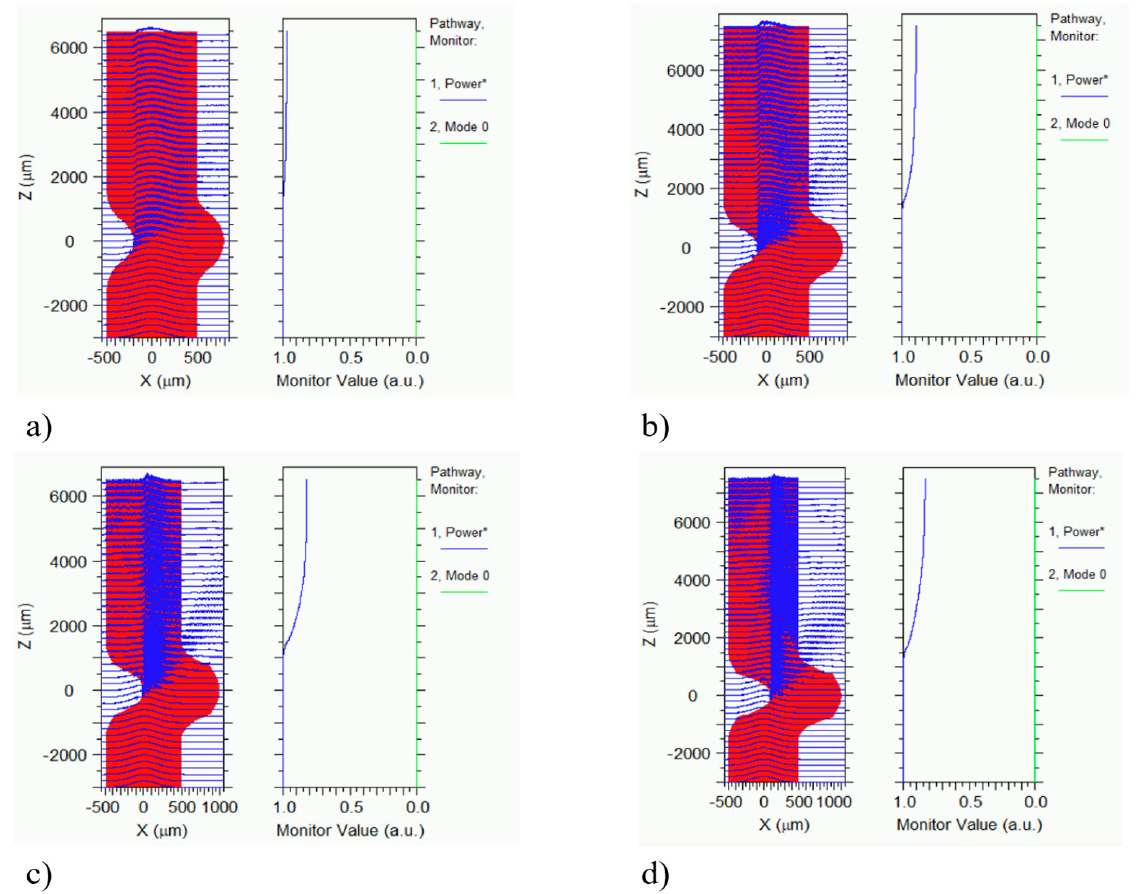
Figure 5. The transmitted optical power with varying bending diameters simulated by Beam-PROP: ( a ) 3.9 mm, ( b ) 3 mm, ( c ) 2.5 mm, ( d ) 2 mm.